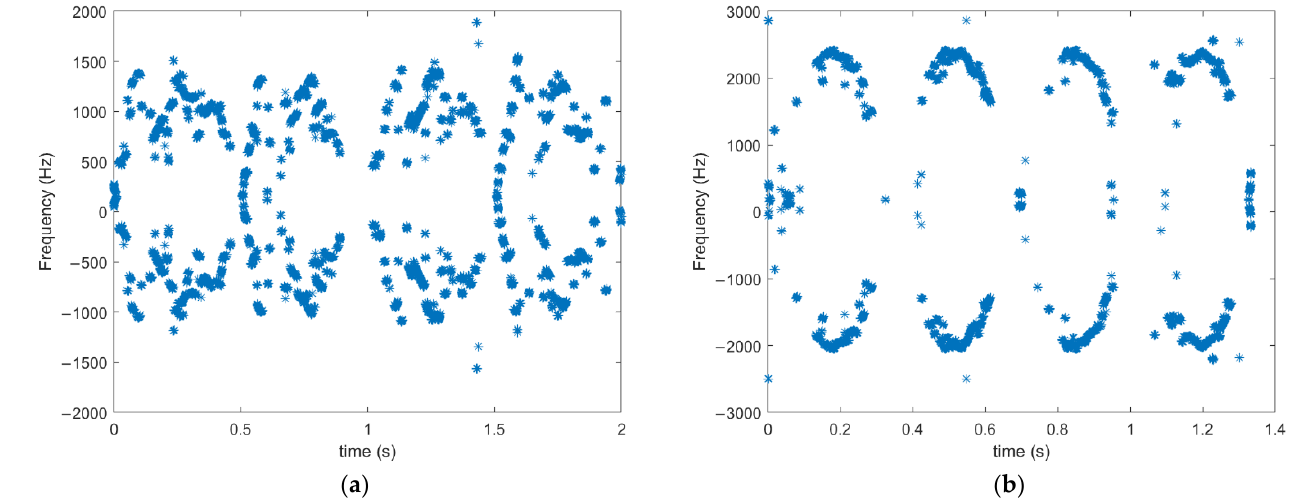
Figure 16. Blade tip discrete time – frequency curves: ( a ) Blade tip discrete time – frequency curve of P1. ( b ) Blade tip discrete time – frequency curve of P2.